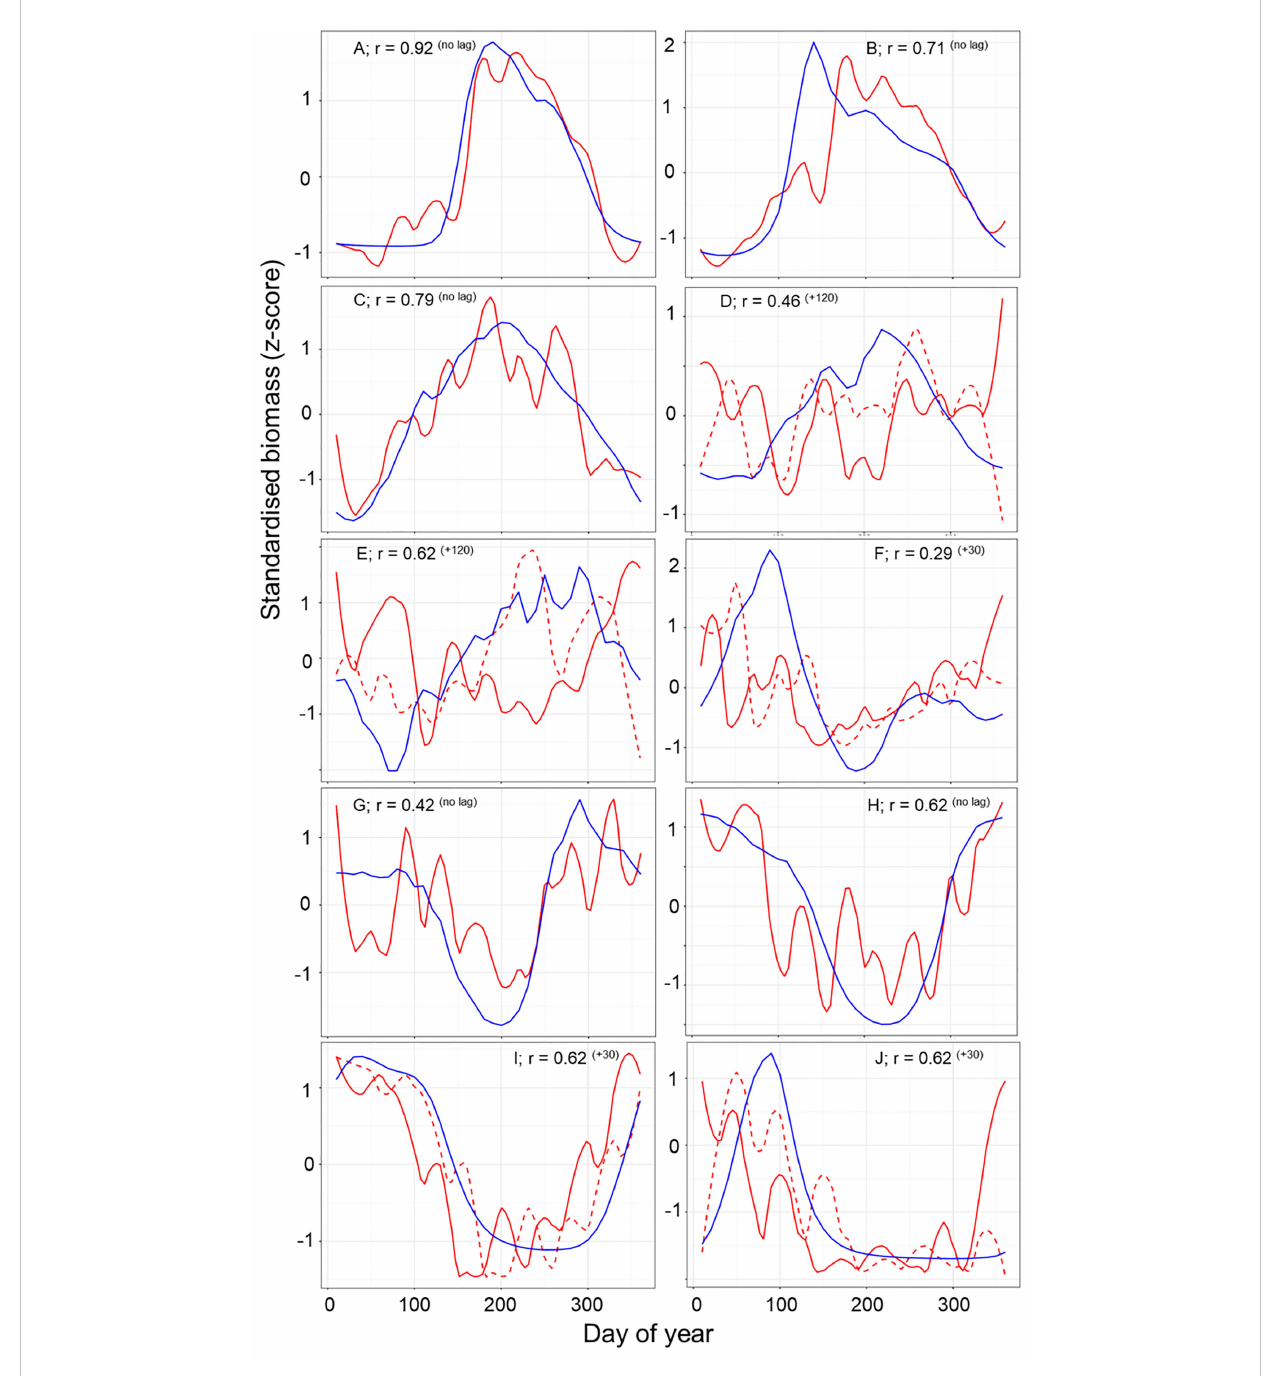
FIGURE 6 A comparison of the normalized seasonal trend for zooplankton data (red line) and model output (blue line) across the full year. Lagged zooplankton data (dashed red line) time series are shown where lagged data improve correlation between model and data. Each panel shows the strongest Pearson correlation (r) between data and model within each of the 10 zooplankton partitions after accounting for temporal lags r (lag) . A positive lag indicates that the model trend is shifted later than the